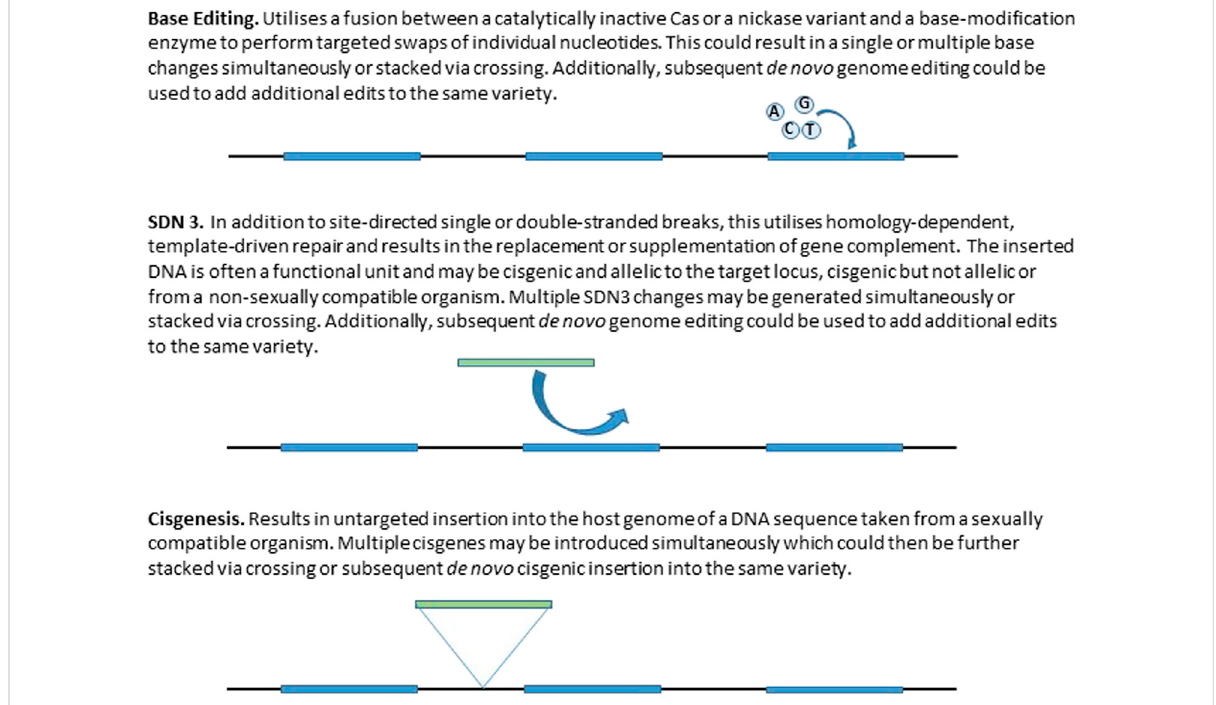
FIGURE 2 Representation of different site directed nuclease (SDN) genome editing approaches and the resulting changes to the host genome.